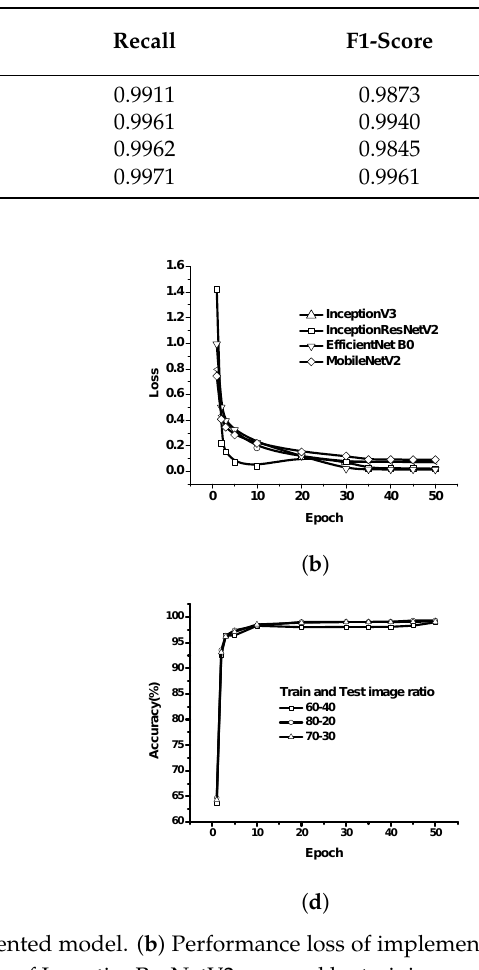
Table 10. Precision, recall, and F1 score of implemented models.